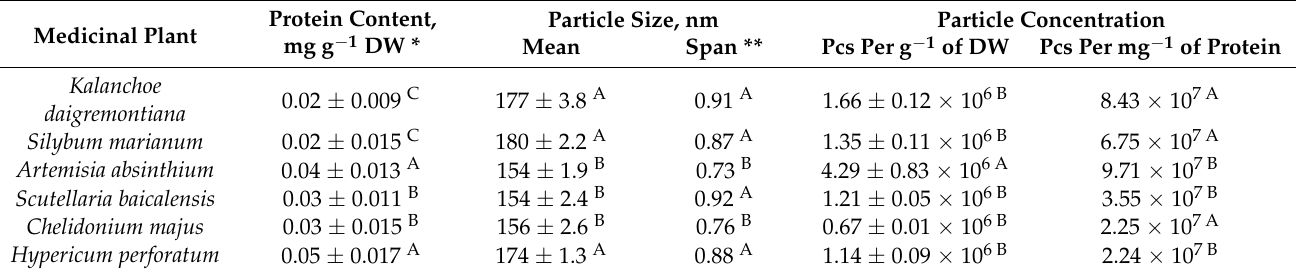
Table 1. Plant-derived nanoparticle yield, size, and number distribution ( 𝑥̅ ± 𝑆𝐷, 𝑛 = 5) . Different letters within the column indicate statistically significant differences between means according to Tukey’s test at the confidence level p ≤ 0.05.